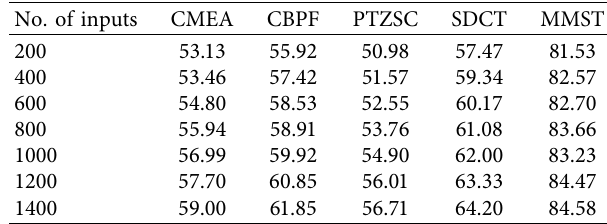
Table 7: Comparison of insect protector